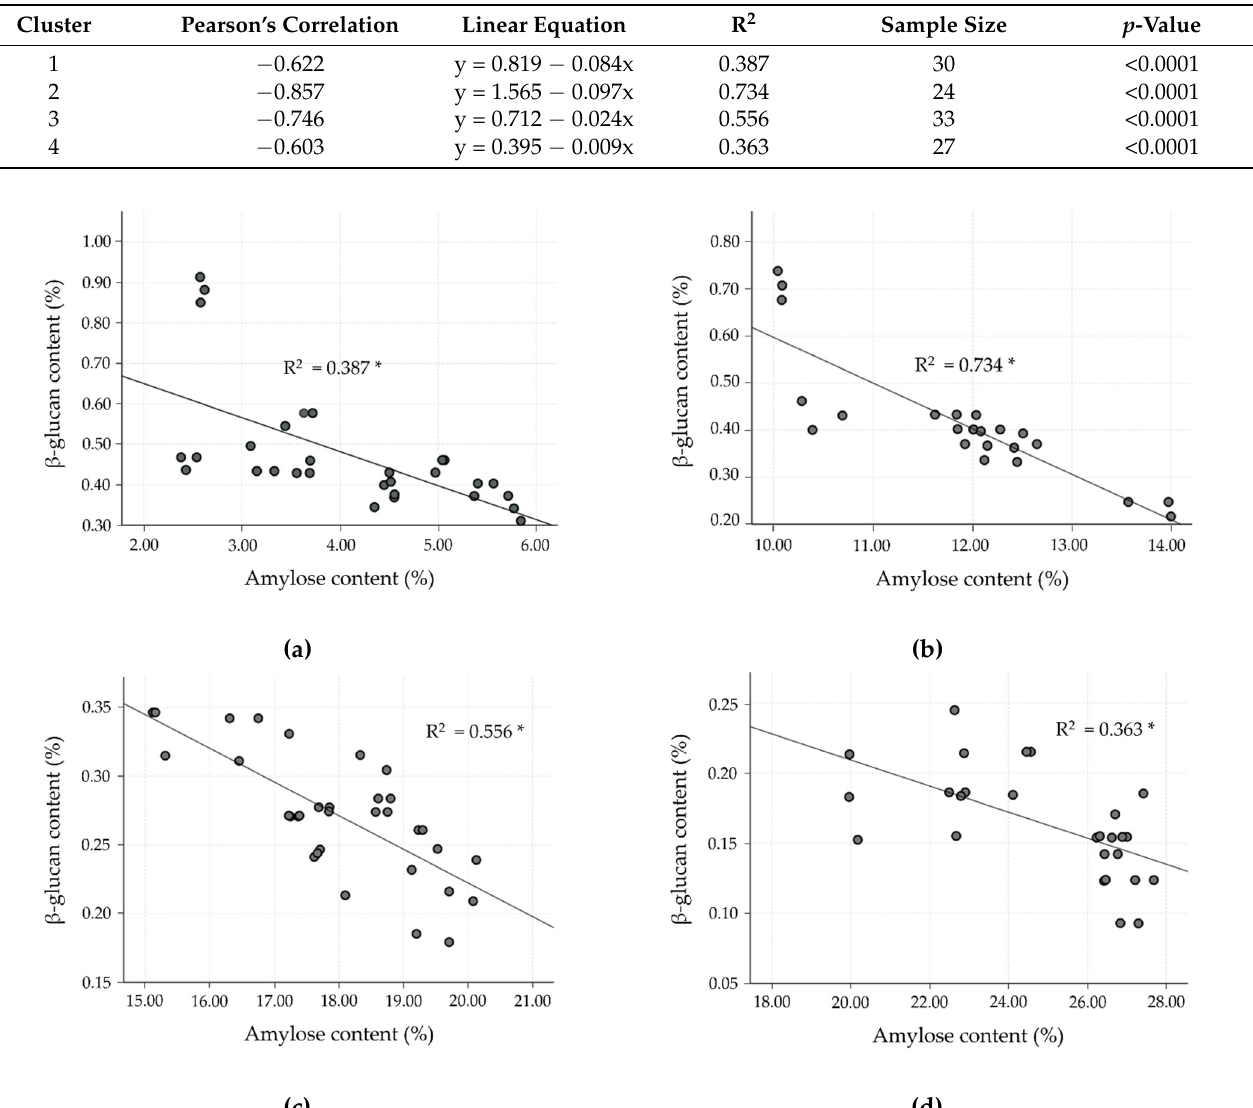
Figure 2. Linear correlation between β-glucan and amylose contents in milled rice fractions of four clusters classified by amylose level. ( a ) Cluster 1: waxy (0–6%); ( b ) cluster 2: very low (>6–14%); ( c ) cluster 3: low (>14–20%); and ( d ) cluster 4: medium (>20–30%). * p < 0.0001.